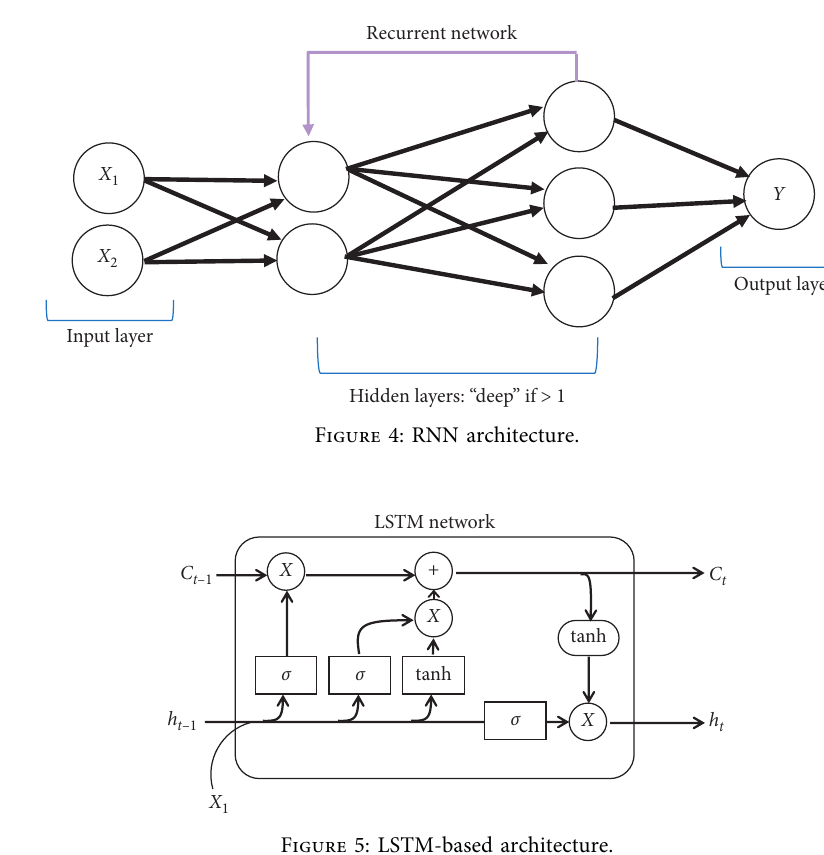
Figure 5: LSTM-based architecture.